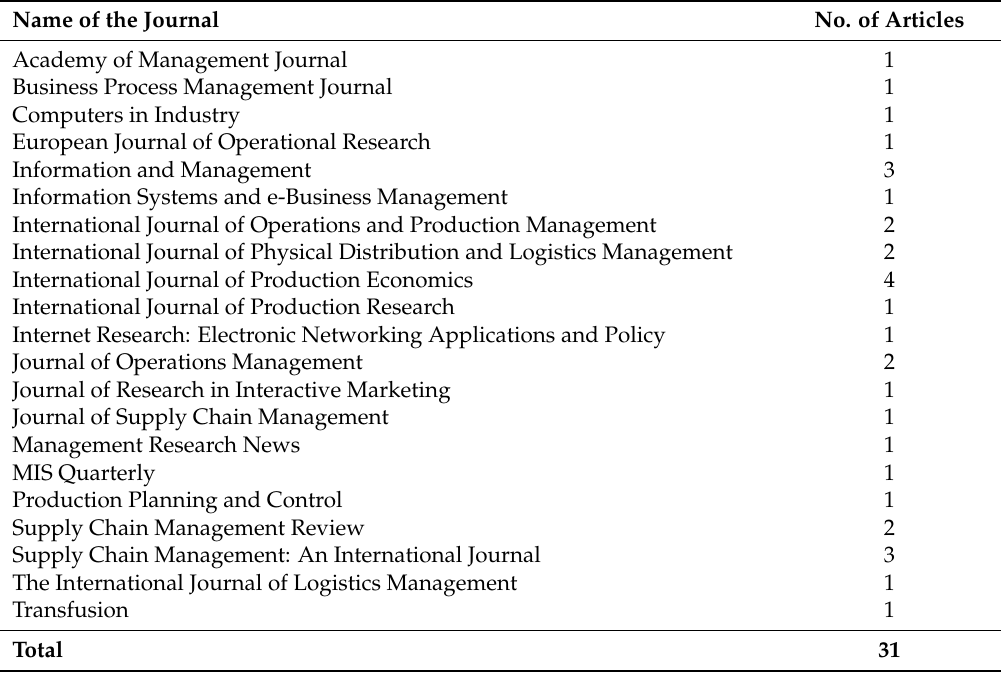
Table 1. Number of Papers by Journal ( N =